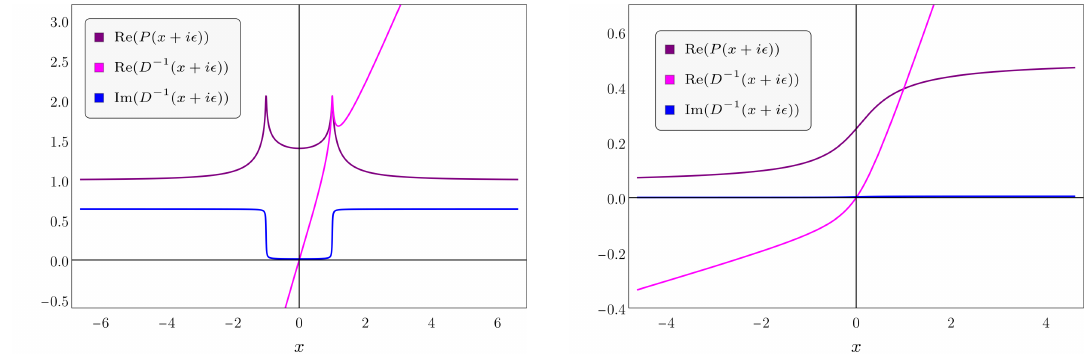
Figure 19 . Real part of the P function (left panel) and spectral density ρ ( z ) (right panel), with z = q 2 m − 2 , associated with the graviton propagator (6.2) for three different values of Z , and for m 2 = 2 and M 2 = 1 (in Planck units). These values are chosen to illustrate the three qualitatively- different cases listed after eq. (6.4).